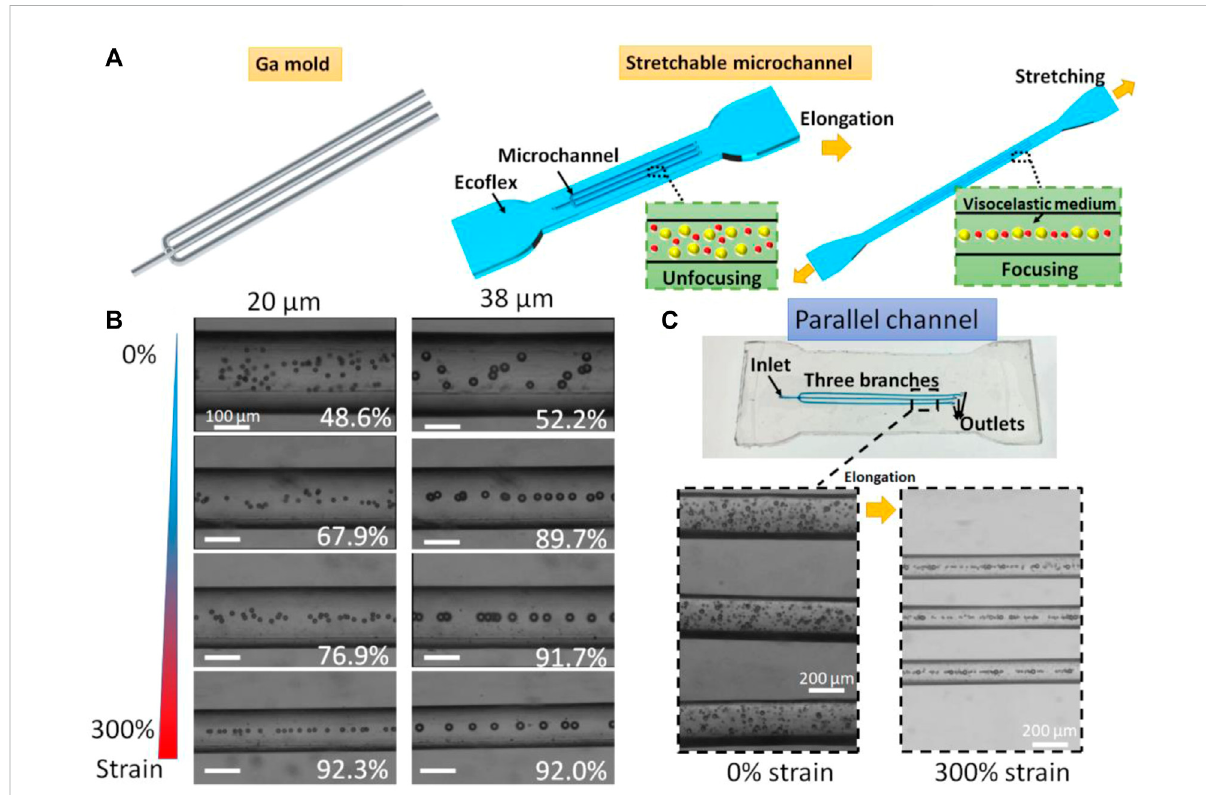
Ultra-stretchable viscoelastic channels. (A) Schematic of ultra-stretchable viscoelastic channels that can tune the focusing cut-off size. (B) Stacked bright fi eld images of 20 μ m and 38 μ m particle migration at different elongations. White numbers represent the focusing ef fi ciencies. (C) Parallel channel with three subchannels that can simultaneously manipulate particles for high